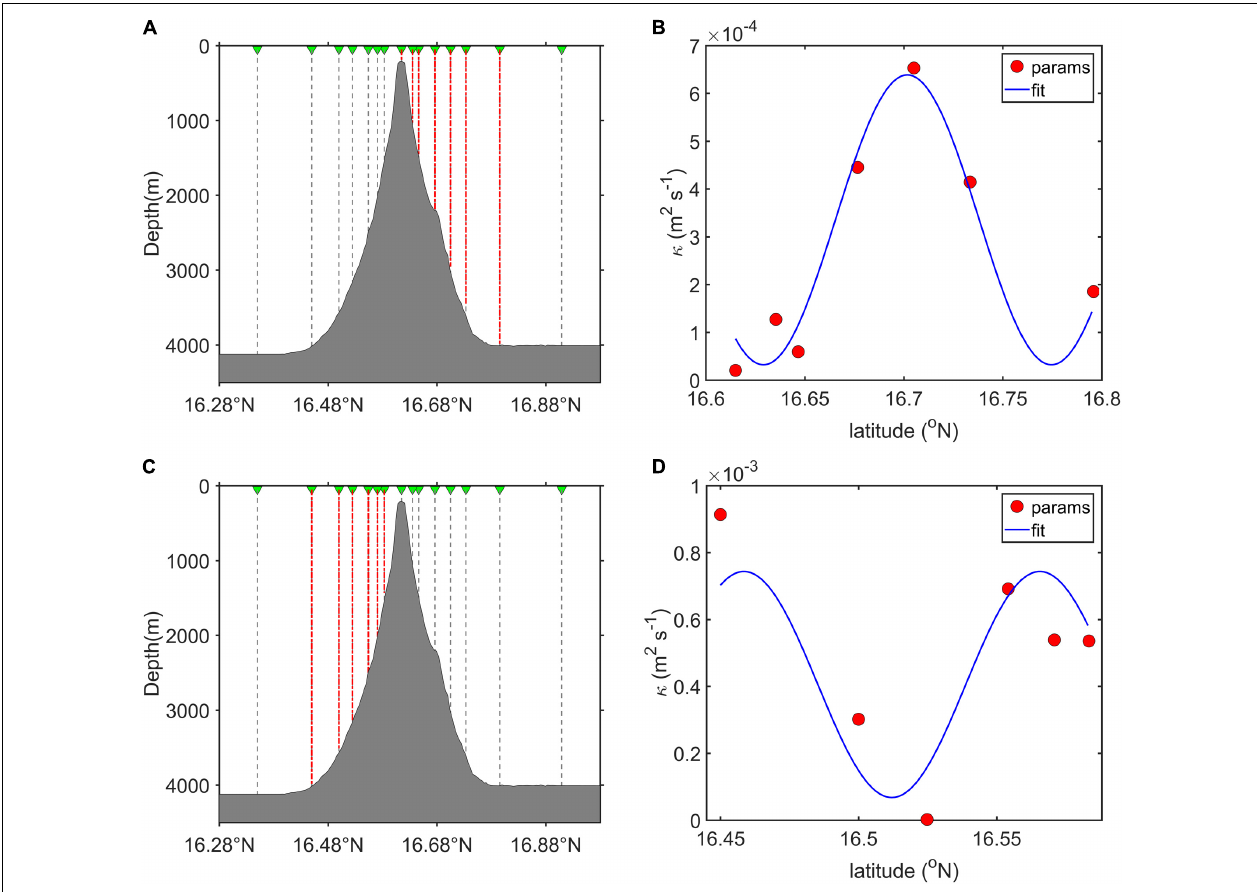
FIGURE 10 | (A,C) Locations of the observed CTD profiles along the meridional section of the seamount in the SCS. (B,D) Upslope distributions of the turbulent diffusivity near the bottom of the north slope and south slope corresponding to the CTD profiles indicated by the red dashed lines in panels (A,C) , respectively. The red dots indicate the turbulent diffusivity near the bottom estimated by the MG parameterization, and the blue solid line is a sine-function fitted